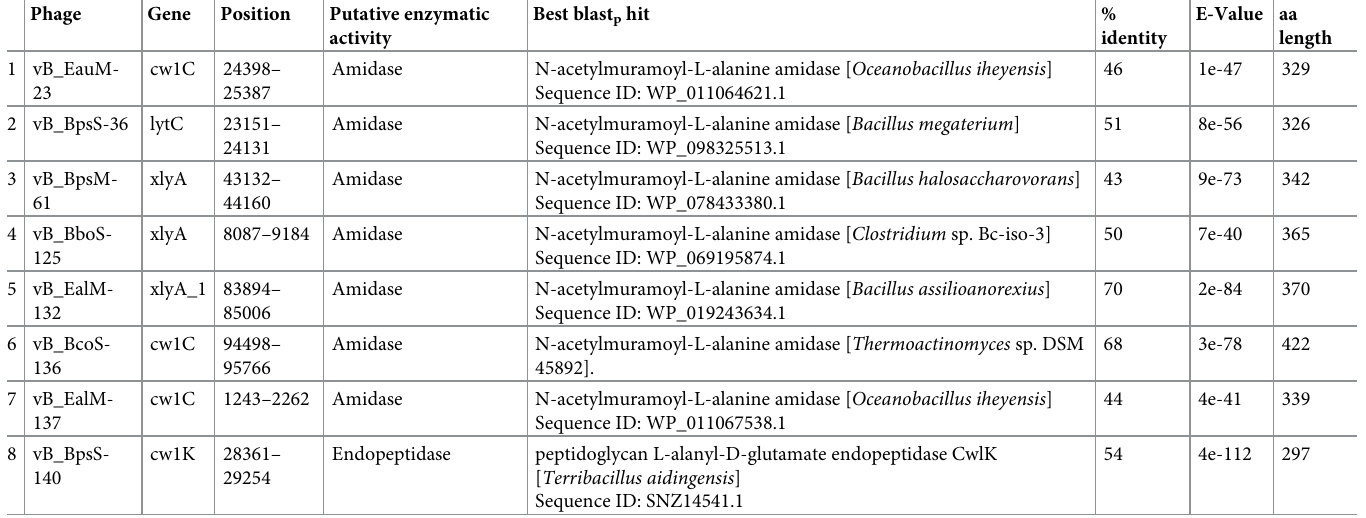
Table 2. Summary of enzymatic activity of phage-derived endolysins of the phages of this study.